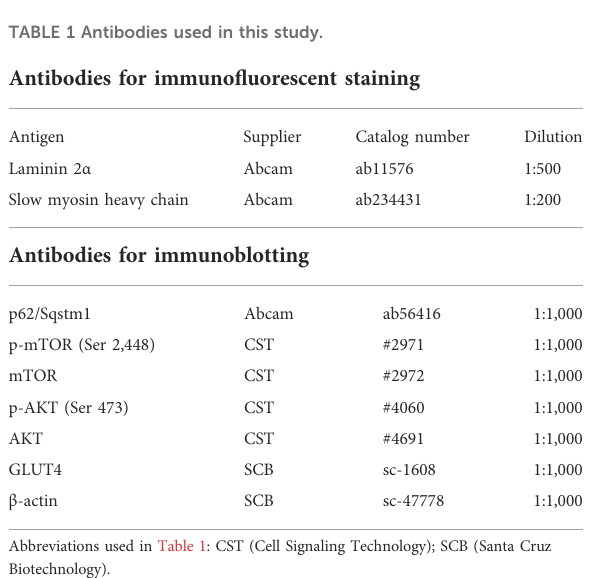
TABLE 1 Antibodies used in this